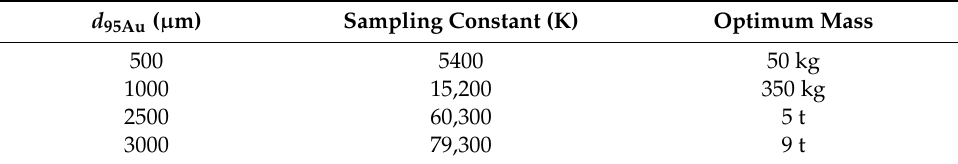
Table 8. Range of theoretical sample mass values for BCOG